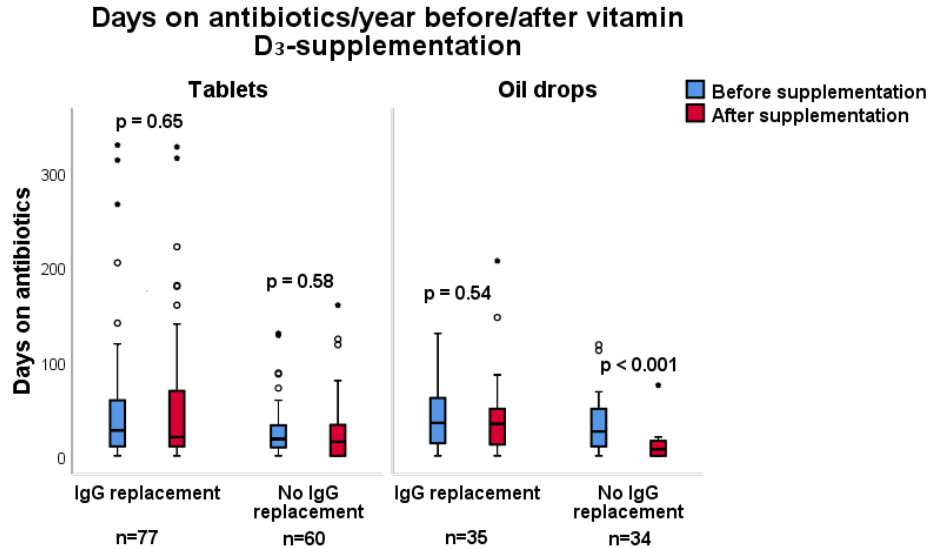
Figure 4. Subgroup analysis comparing immunodeficient patients with immunoglobulin (IgG) replacement to patients without IgG replacement, regarding the e ff ect of vitamin D 3 supplementation as oil drops (1500 IE / day) or as tablets (1600 IE / day) for one year and antibiotic requirements, expressed as number of days on antibiotics. Patients are their own controls, and the 12 month period before supplementation is compared to the 12 month supplementation period. In patients without immunoglobulin replacement therapy who were supplemented with oil drops ( n = 34), the median number of days on antibiotics decreased from 26 (0–118) to 7 (0–75), p < 0.001 (Wilcoxon matched pairs signed rank test).